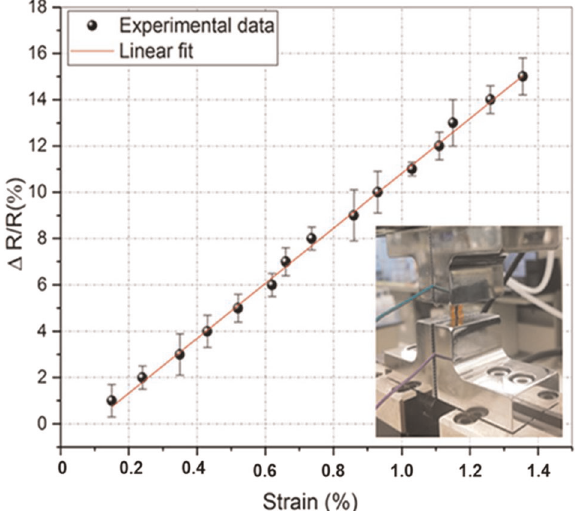
Fig. 2 Strain-induced resistance change of LIG